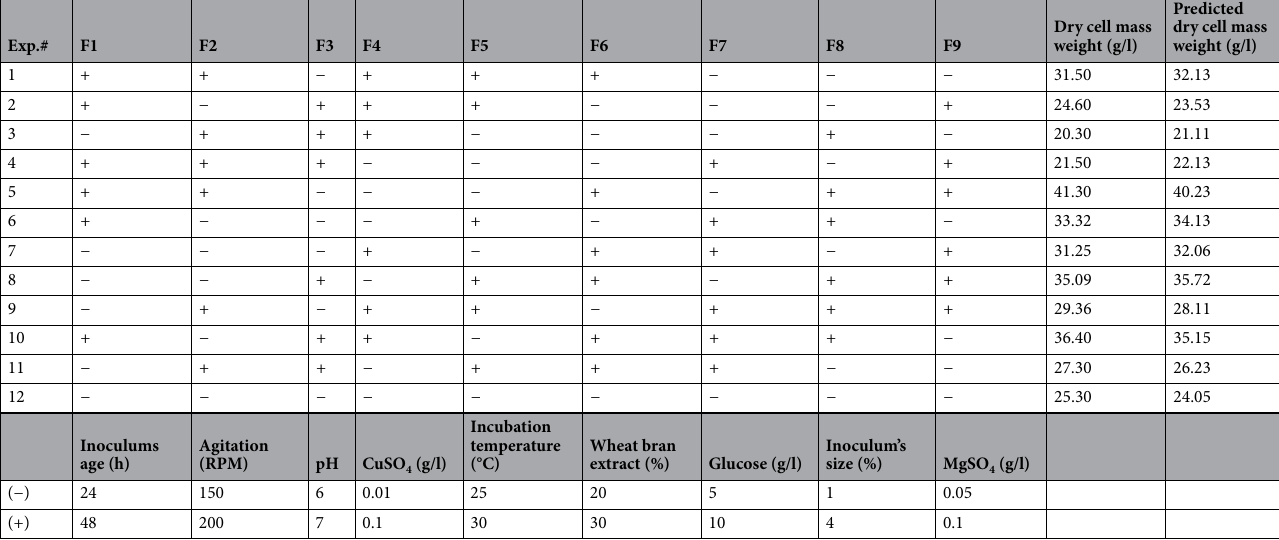
Table 3. Matrix of Plackett–Burman experimental design for optimizing the biomass production of endophytic Trichoderma virens strain EG92, showed the coded and actual values for tested variables besides the experimental and predicted results for dry cell mass